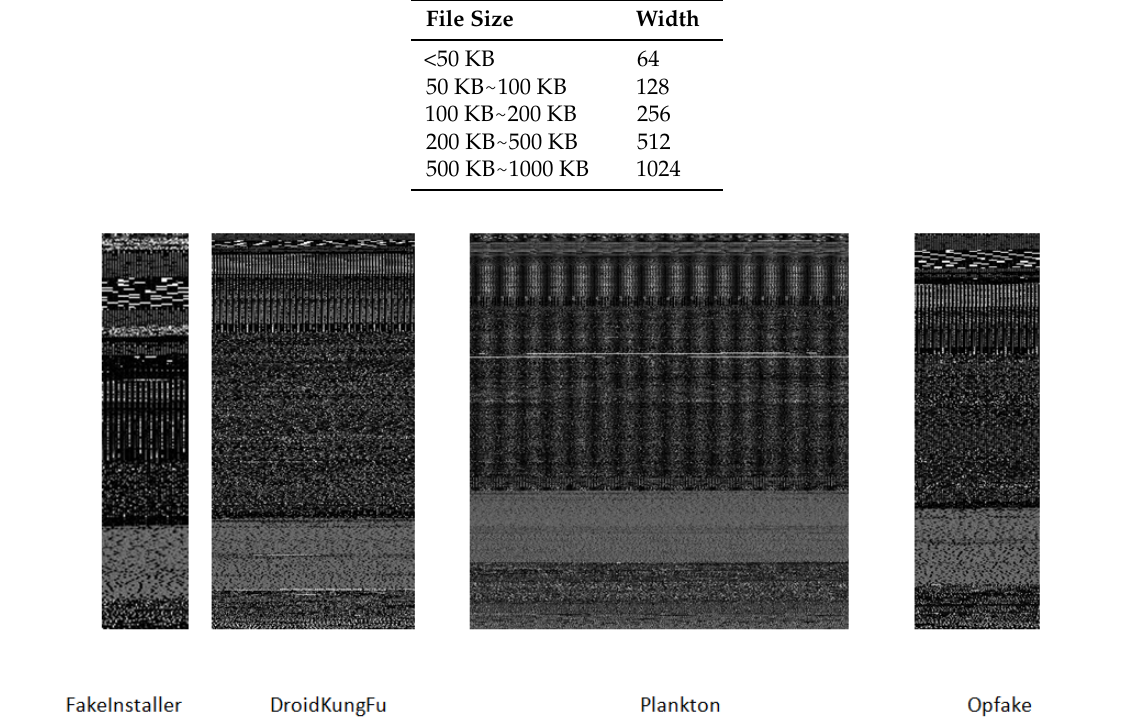
Figure 4. Illustration of malware images using the file sections of certificate (CR),Android manifest (AM), resource (RS), classes.dex (CL) of an APK.